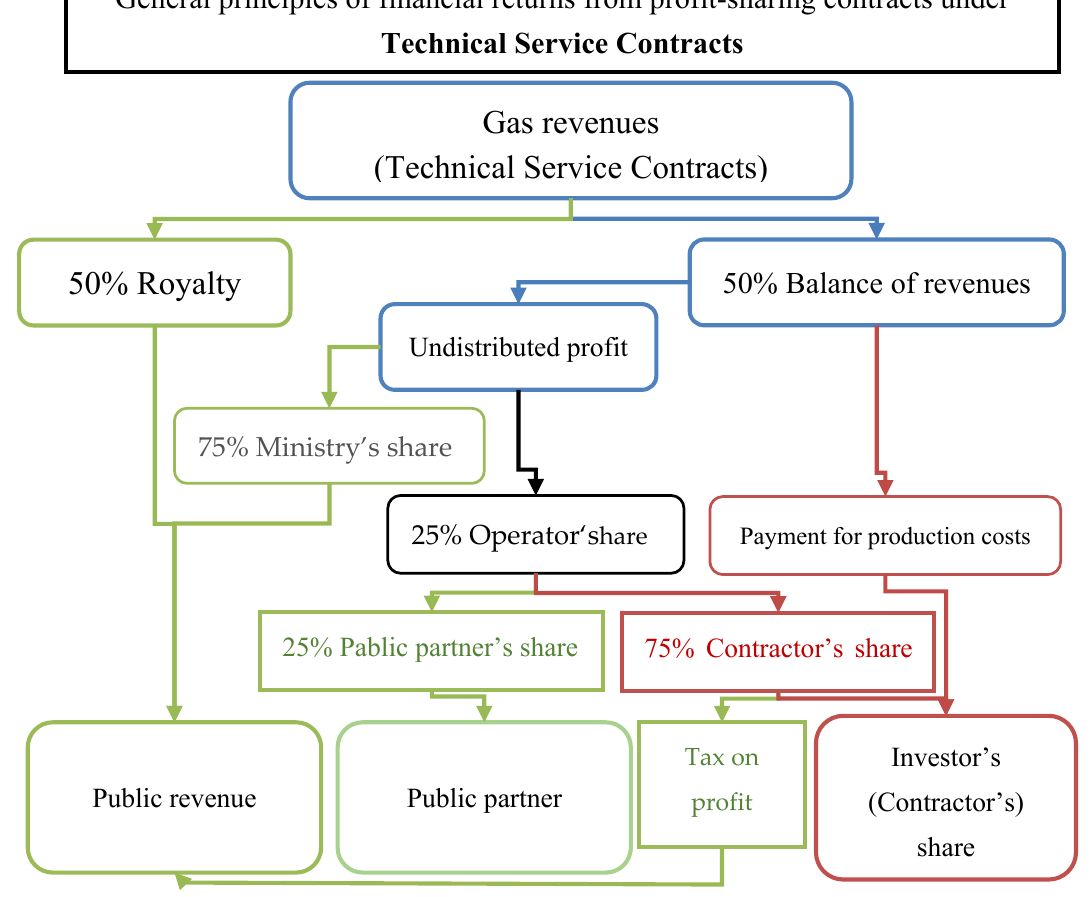
Figure 6. Methodological approach to revenue ‐ sharing while investing in free gas.